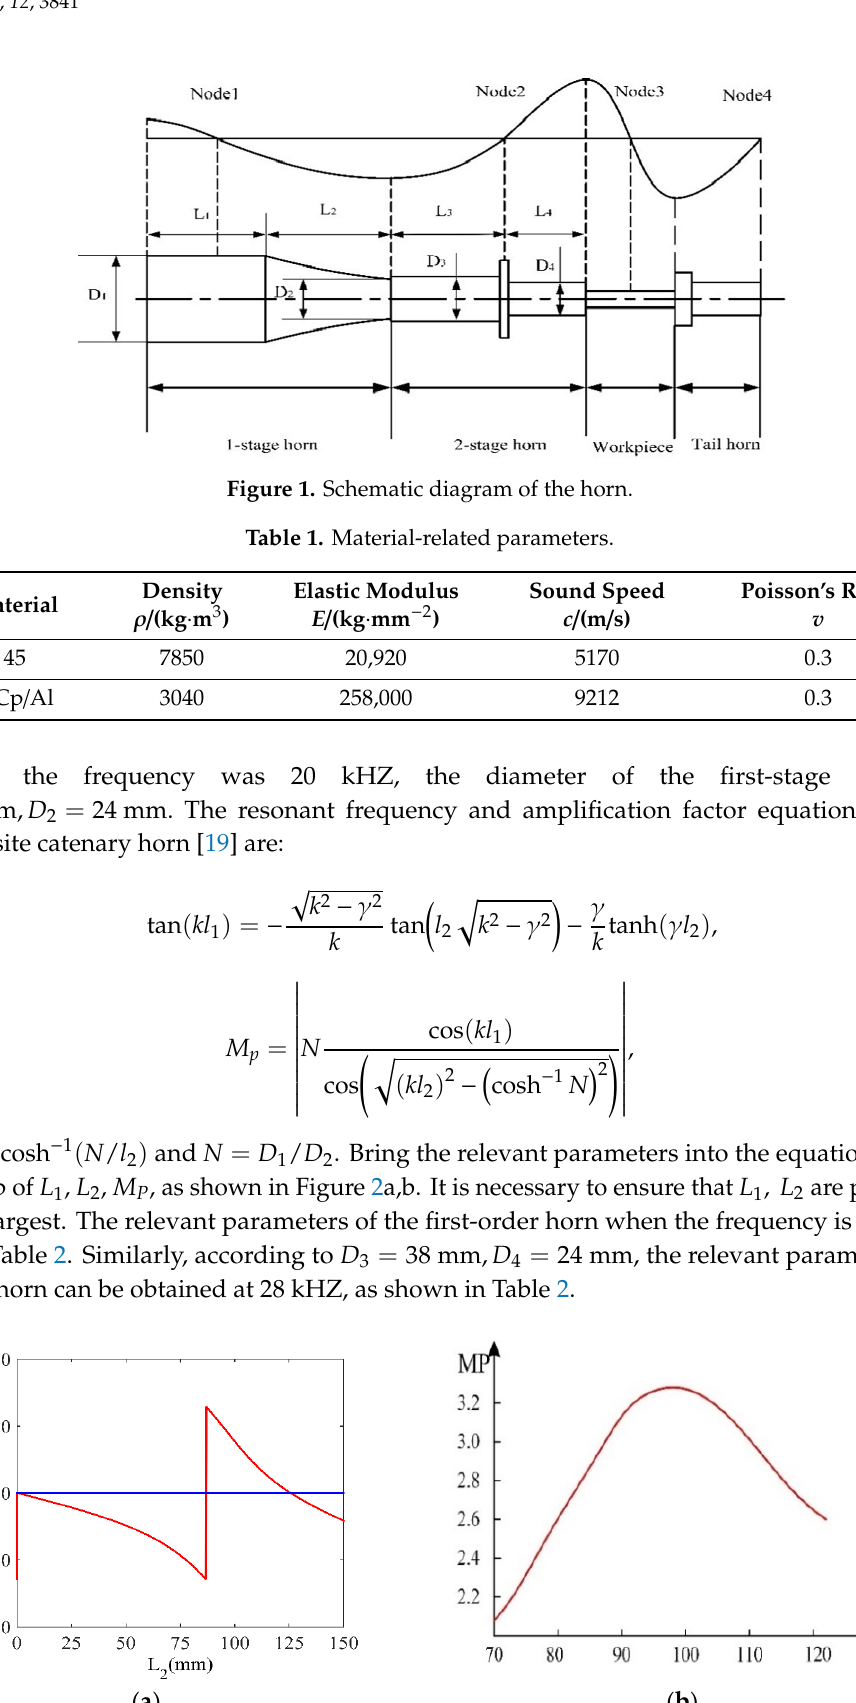
Figure 2. ( a ) Relationship between L 1 and L 2 ; ( b ) Relationship between M P and L 2 Table 2. 1 stage horn parameters.